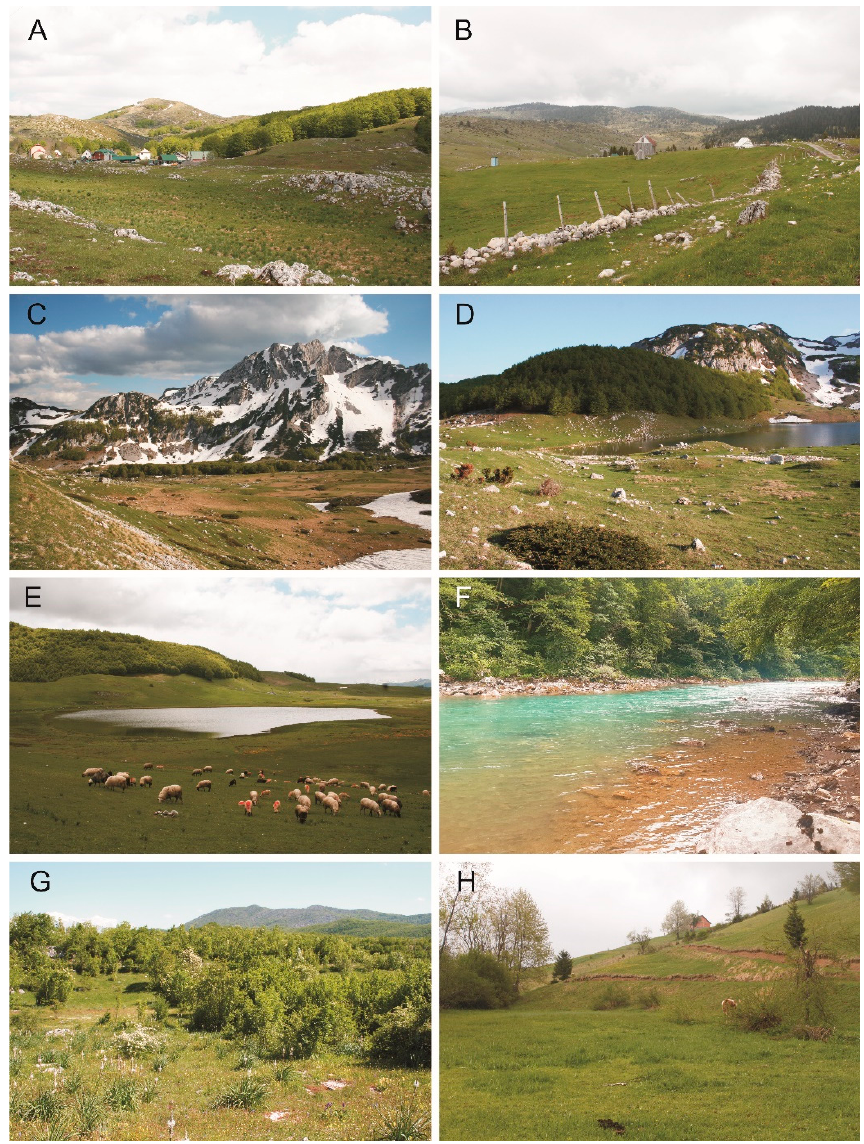
Figure 2. Collection localities of the scarabaeoid beetles in Montenegro (2019, 2021): ( A )—Trsa at Plužine, ( B )—Mala Crna Gora at Žabljak, ( C , D )—Stožina at Žabljak, ( E )—Poš ć enski Kraj at Žabljak, ( F )—Dobrilovina at Mojkovac, ( G )—Donje Srijede at Presjeka, ( H )—Grahovo at Rožaje (Photos: ( A , C – E , G )—Tomasz Gazurek, ( B , H )—Sebastian Tylkowski and ( F )—Dawid Marczak).